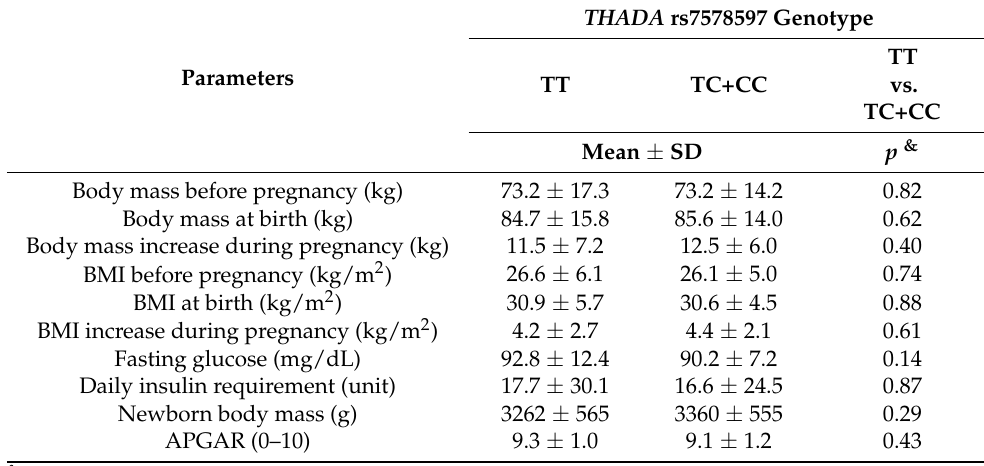
Table 2. Clinical parameters of women with GDM stratified according to THADA rs7578597 genotype [21–23].